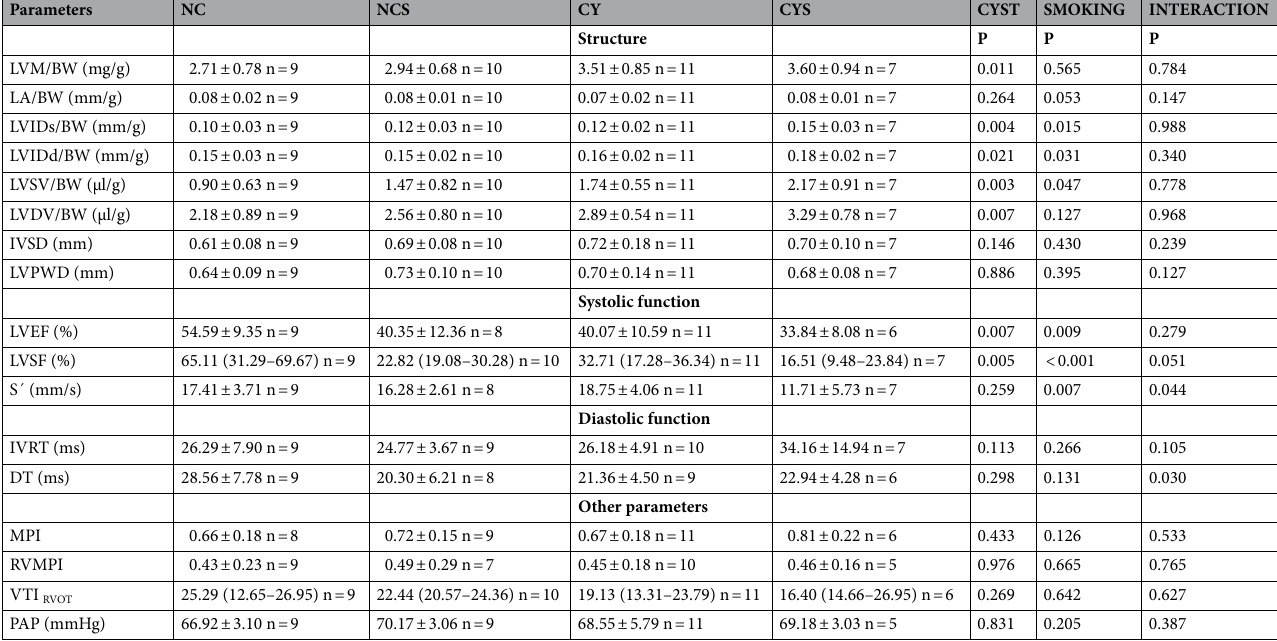
Table 1. Echocardiographic parameters in NC, NCS, CY and CYS mice. LVM/BW left ventricular mass adjusted to body weight, LA/BW left atrium diameter adjusted to body weight, LVIDs/BW) left ventricular internal diameter in systole adjusted to body weight, LVIDd/BW left ventricular internal diameter in diastole adjusted to body weight, LVSV/BW left ventricular volume in systole adjusted to body weight, LVDV/BW left ventricular volume in diastole adjusted to body weight, IVSD intraventricular septum diameter, LVPWD left ventricular posterior wall diameter , LVEF left ventricular ejection fraction. LVSF left ventricular shortening fraction, S’ peak velocity at the septal basal level, IVRT isovolumetric relaxation time, DT mitral valve deceleration time, MPI myocardial performance index, RVMPI right ventricular myocardial performance index, VTI RVOT velocity–time integral of the right ventricular outflow tract, and PAP mean pulmonary artery pressure. Two-way analyses of variance were performed for parametric data and aligned rank transform followed by two-way analysis of variance were performed for non-parametric